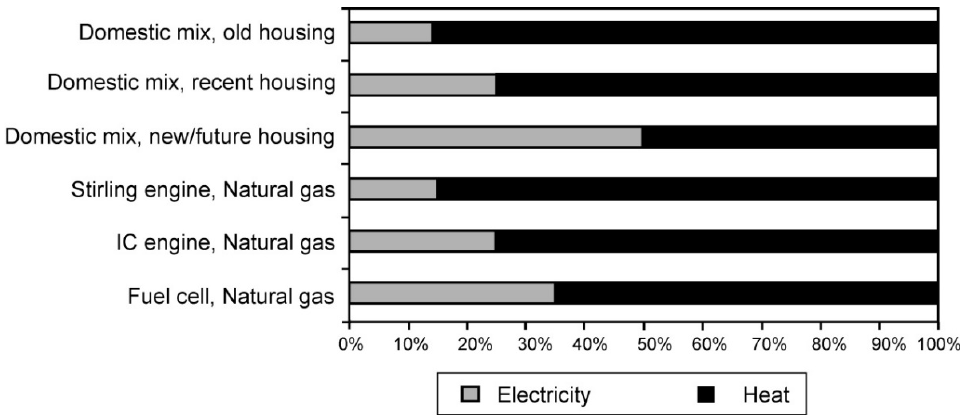
Figure 7. Electricity and heat requirements for UK housing stock and potential mCHP plant outputs. Source: Reprinted with permission from Ref. [18]. 2011, University of Nis—Faculty of Mechanical Engineering.